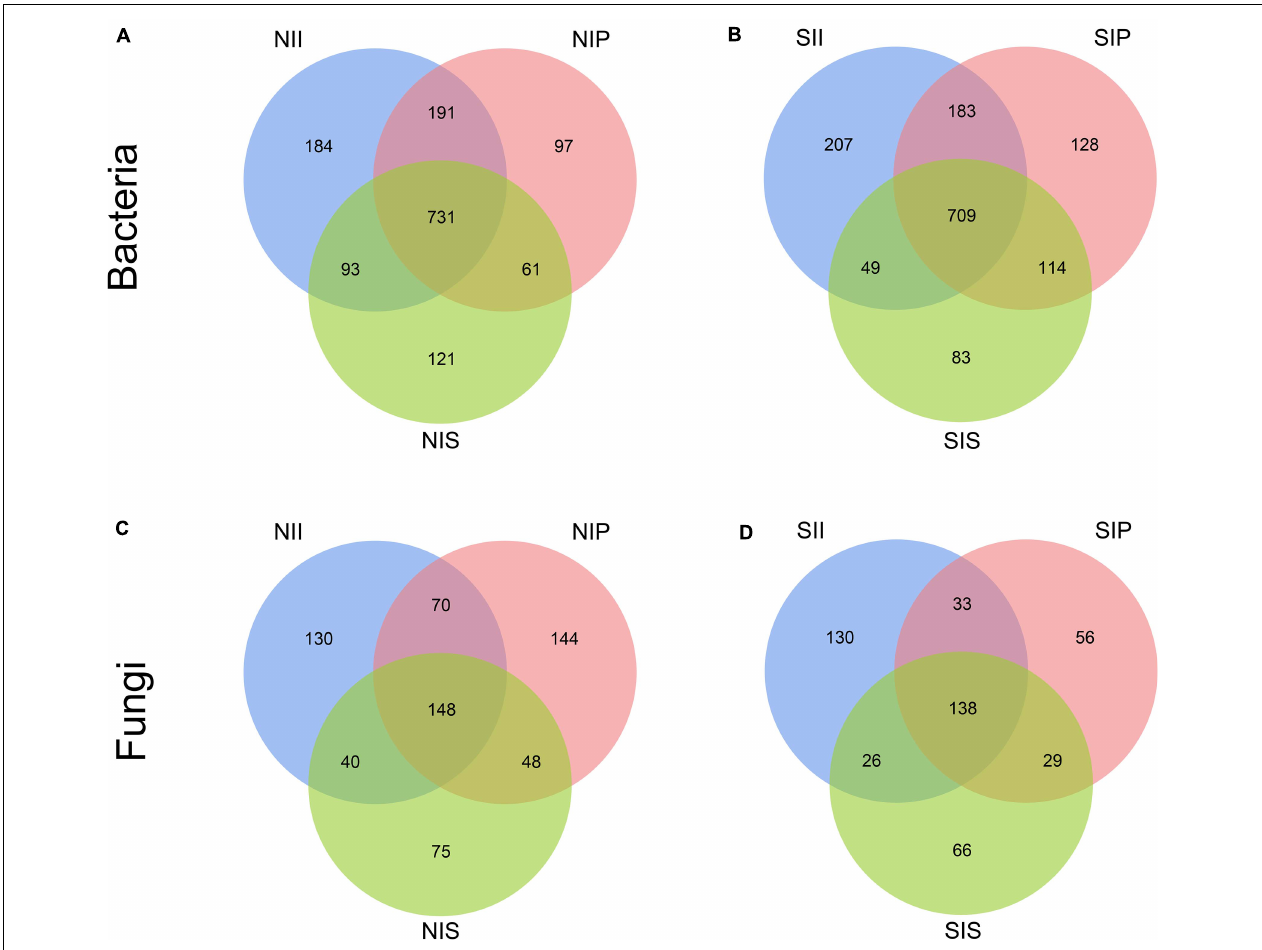
FIGURE 2 | Venn diagrams showing the unique and shared operational taxonomic units (OTUs) (5% distance level) between the peanut rhizosphere (IP), sorghum rhizosphere (IS), and interspecific interaction zone (II) (S, 0.25% salt-treated soil condition; N, normal soil condition). (A) Venn diagrams of bacterial operational taxonomic units (OTUs) under normal soil condition. (B) Venn diagrams of bacterial OTUs under salt-treated soil condition. (C) Venn diagrams of fungal OTUs under normal soil condition. (D) Venn diagrams of fungal OTUs under salt-treated soil